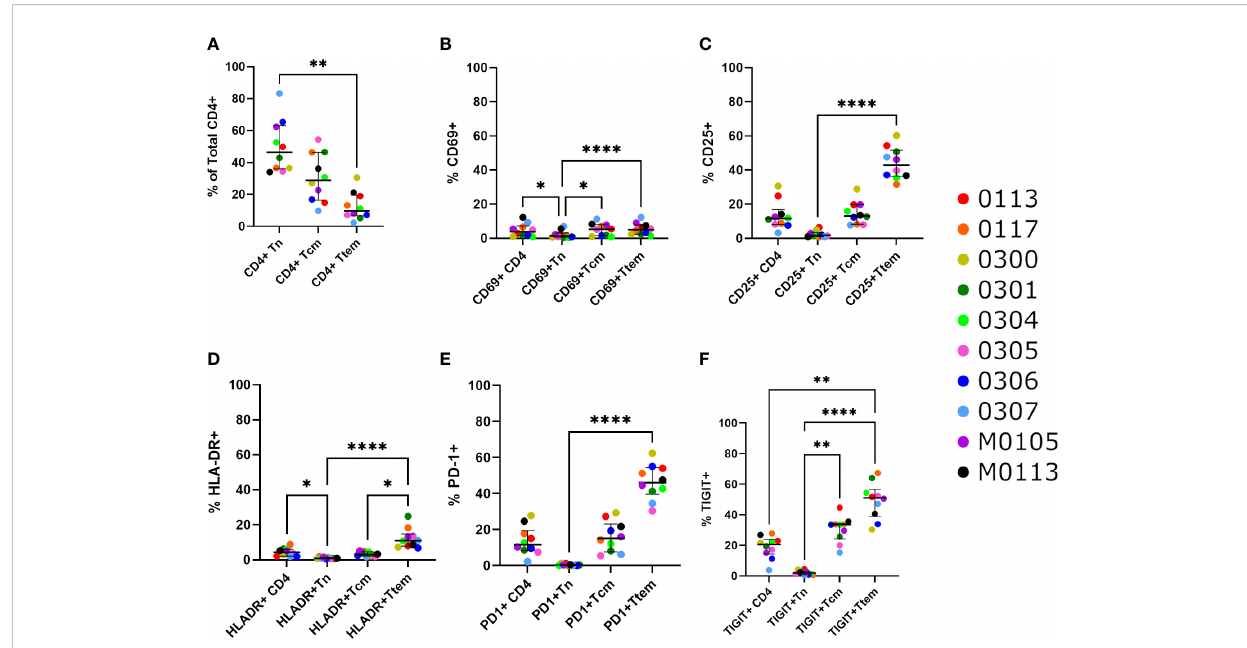
FIGURE 2 Activation and exhaustion markers on CD4+ T cell subsets. (A) Percentage of naïve CD4+ T cells (CD3+CD4+CCR7+CD45RA+CD28+), central memory CD4+ T cells (CD3+CD4+CCR7+CD45RA-CD28+) and a combination of transition (CD3+CD4+CCR7-CD45RA-CD28+) and effector (CD3 +CD4+CCR7-CD45RA-CD28-) memory CD4+ T cells within the CD3+CD4+ T cell population. (B-F) The percentage of cells with the activation markers (B) CD69, (C) CD25 and (D) HLA-DR, and the exhaustion markers (E) PD-1 and (F) TIGIT, within CD4+ T cells. Signi fi cance is determined by a Friedman test with Dunn ’ s multiple comparison test (*p < 0.05, **p < 0.01, ***p < 0.001, ****p <